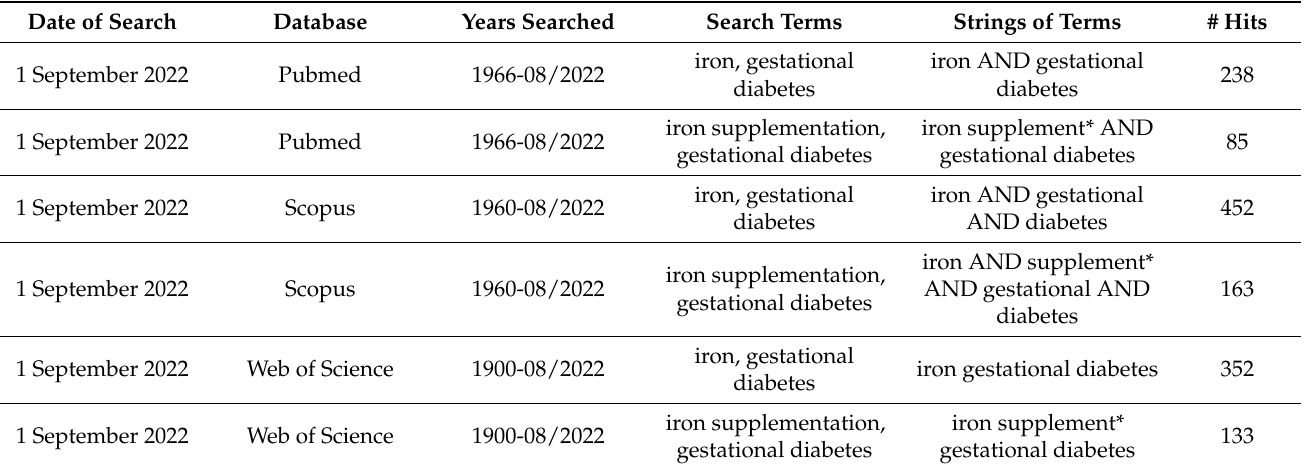
Table 1. The search criteria and databases used to find manuscripts for this review.